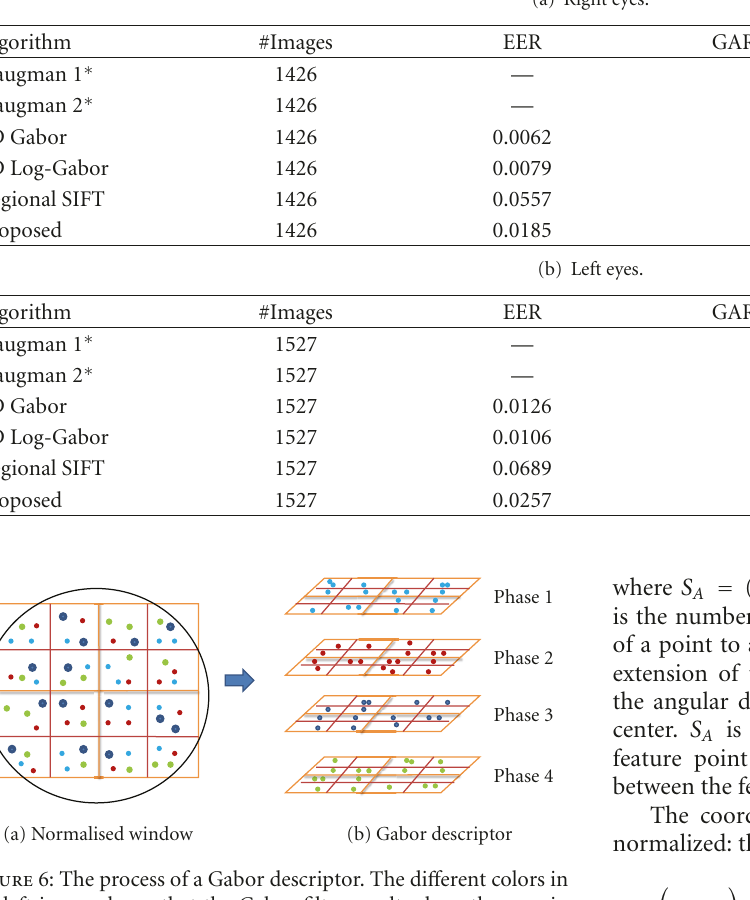
Table 1: ICE 2005 database matching results. ∗ In the NIST ICE Phase 2005, Duagman 1 and Duagman 2 were listed as Cam 1 and Cam 2. The EERs are not clear to view from the report. The GAR at FAR = 01% and GAR at FAR = 0.01% were taken from the plot of the report in [30].